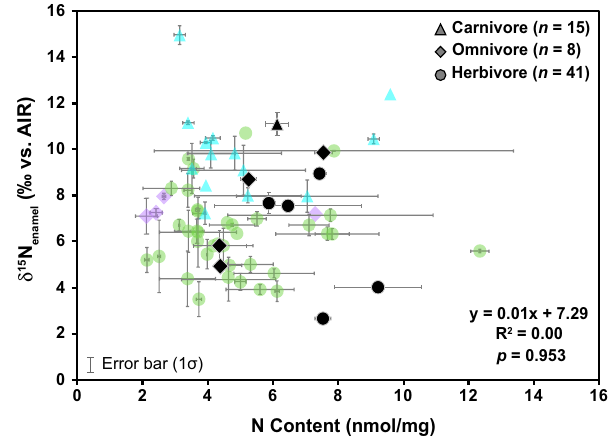
Fig. 4 δ 15 N enamel versus N content of modern African mammals (colored symbols) and Tam Hay Marklot fossil mammals (black symbols). The equation for the regression, R 2 value, and p value are indicated in the lower right of the fi gure. Fossil tooth enamel N content falls within the range of modern mammalian tooth enamel N content. δ 15 N enamel and N content are not signi fi cantly